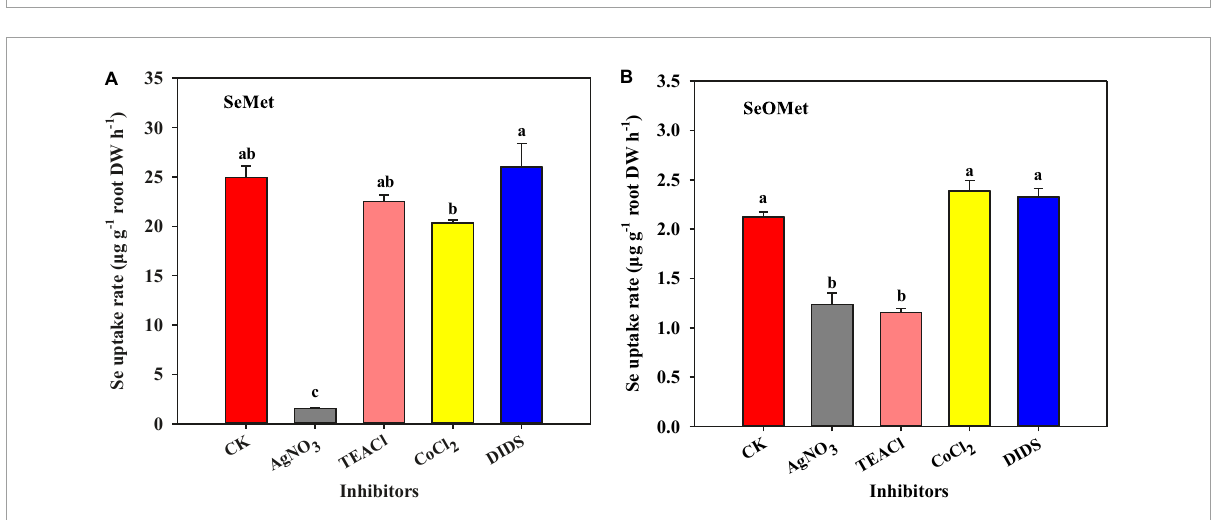
FIGURE3 Effect of different specific inhibitors on the uptake of Se by rice supplied with SeMet (A) and SeOMet (B) . Data are presented as mean + SE ( n = 4). Different lowercase letters above bars indicate significant differences among the inhibitor treatments ( P <